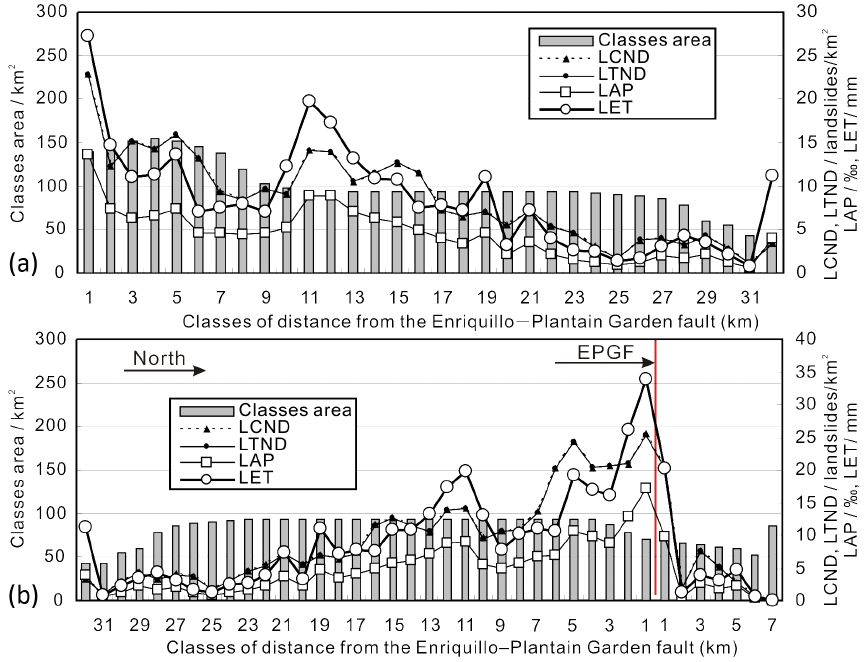
Figure 23. Relationships of co-seismic landslides and distance from the Enriquillo–Plantain Garden fault. (a) Wwithout considering the differences on the two sides of the fault, (b) considering the differences on the two sides of the